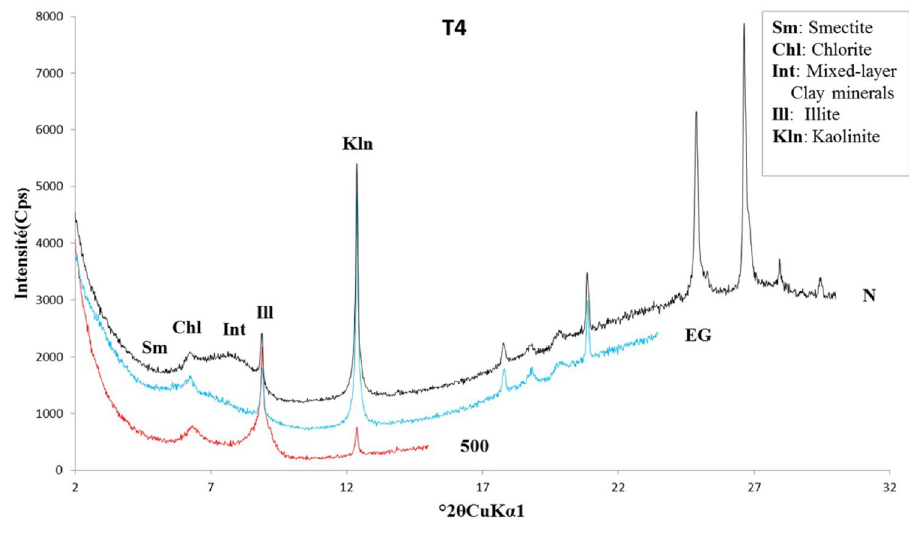
Fig. 8 X-ray diffraction pattern for bulk mineralogy “random powders” ( Sample: T4 )